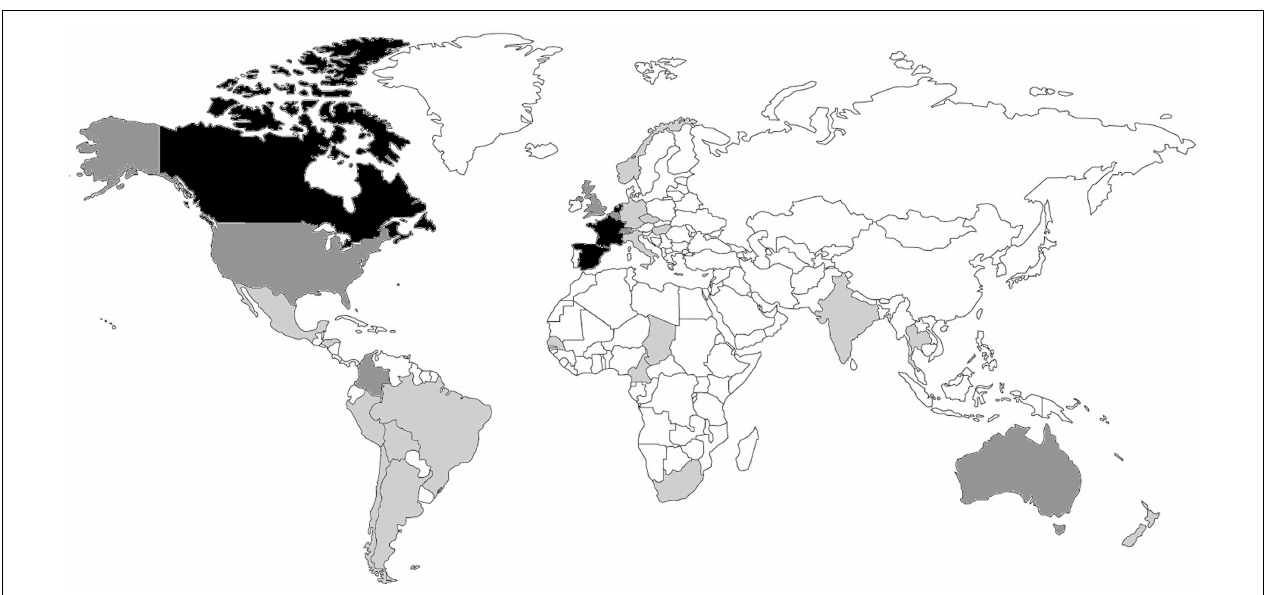
FIGURE 1 | Country of origin of the specialists ( n = 269) .The countries are shaded: light gray, < 5 specialists; dark gray, 5–25 specialists; black, > 25 specialists.